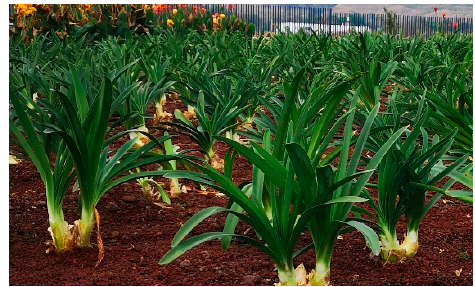
Figure 1. Agapanthus africanus planted in the horizontal flow constructed wetland (HFCW).